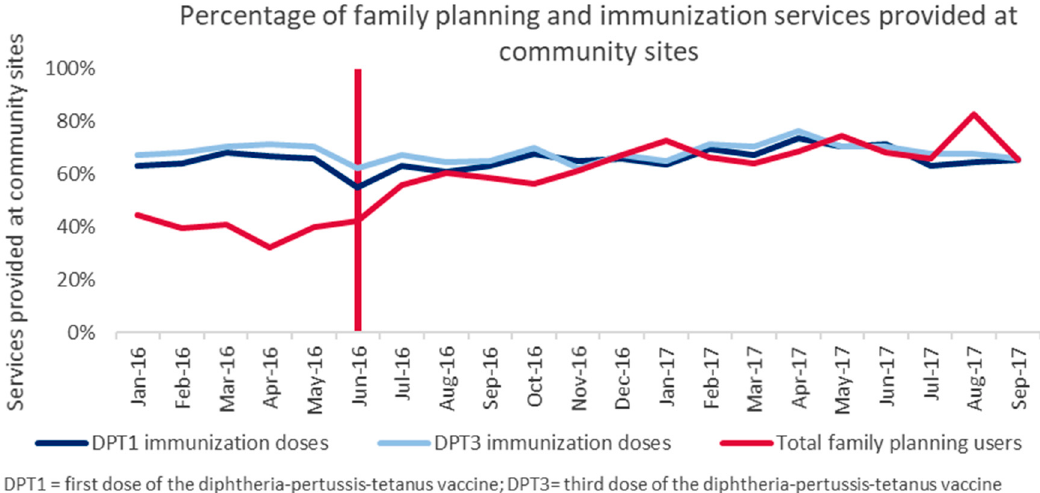
Figure 5. Percentage contraceptive methods and immunization doses administered at the community level in Dowa